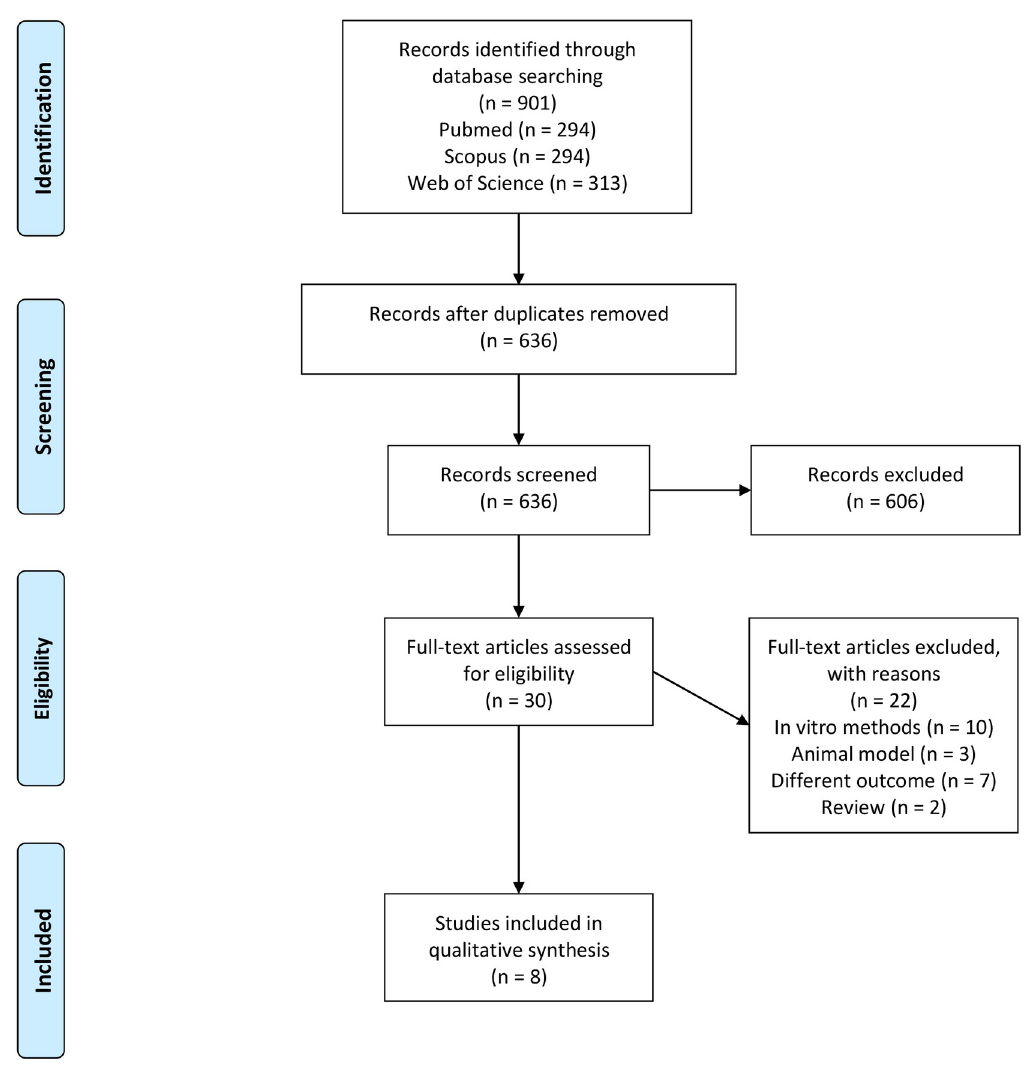
Fig 1. PRISMA flow diagram